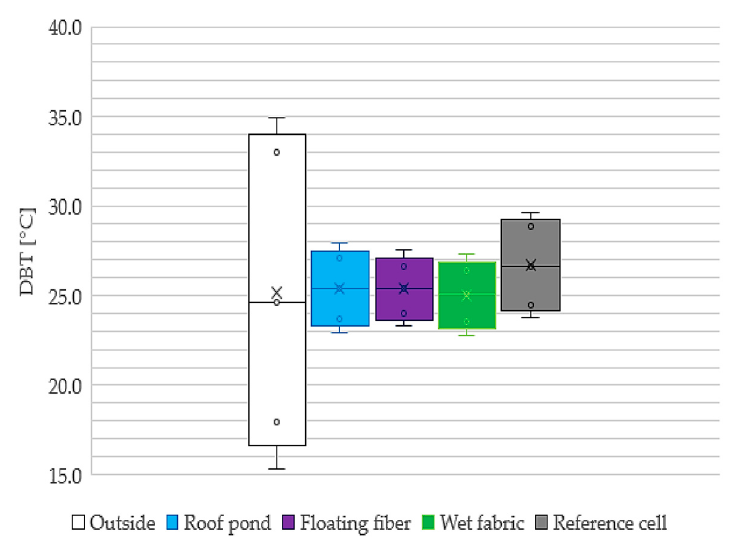
Figure 10. Box plot of the indoor air temperatures in the warm sub ‐ humid season.